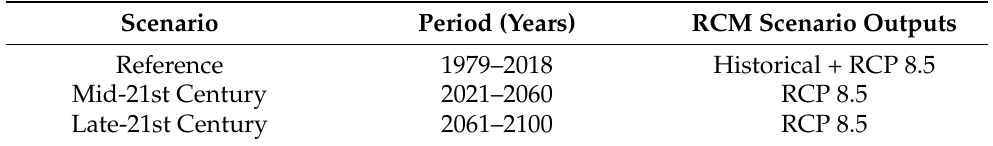
Table 2. Definitions of climate change